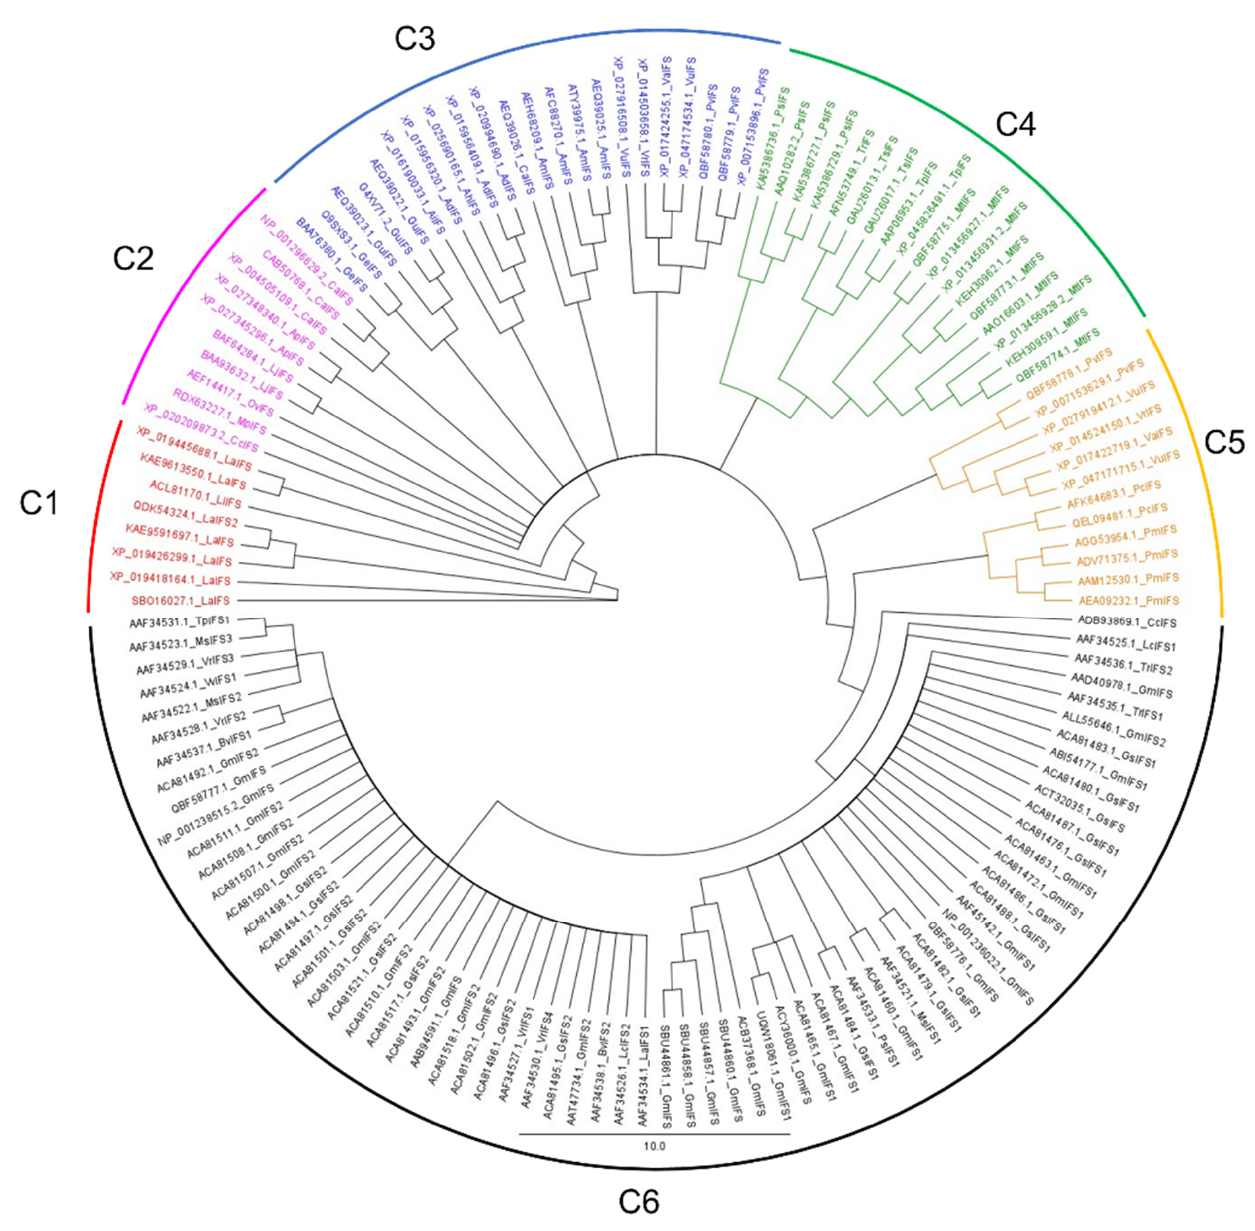
Figure 3. Phylogenetic tree of IFS amino acid sequences. The phylogenetic tree is constructed using the Neighbour Joining (NJ) algorithm for 139 IFS amino acid sequences. Branch labels represent the NCBI accession number followed by species name initials and IFS isoform number. Colours are used to differentiate between clades. The scale bar represents amino acid substitutions per site.